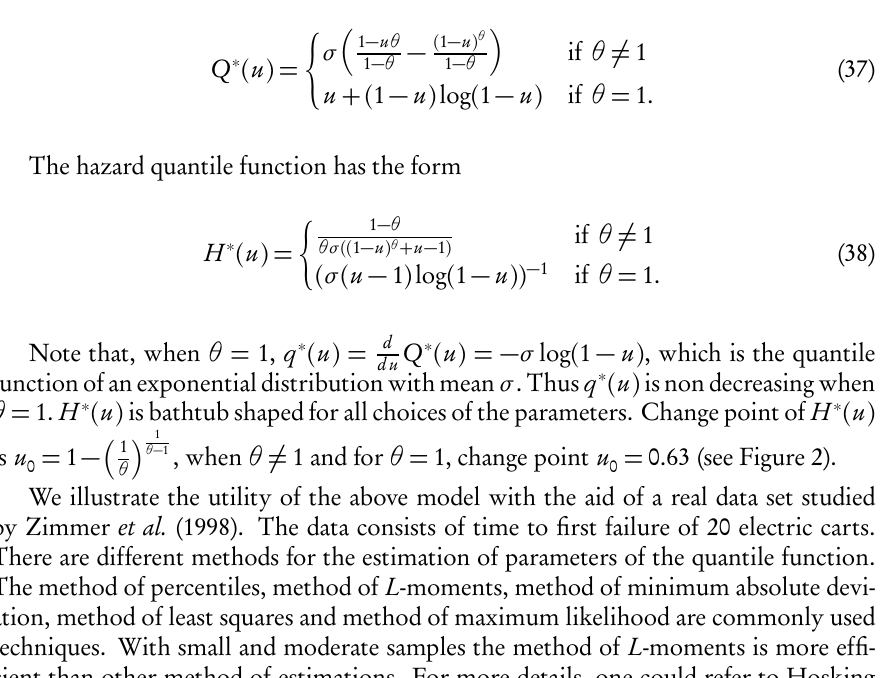
( u ) ) with T ∗ PH 1 − θ